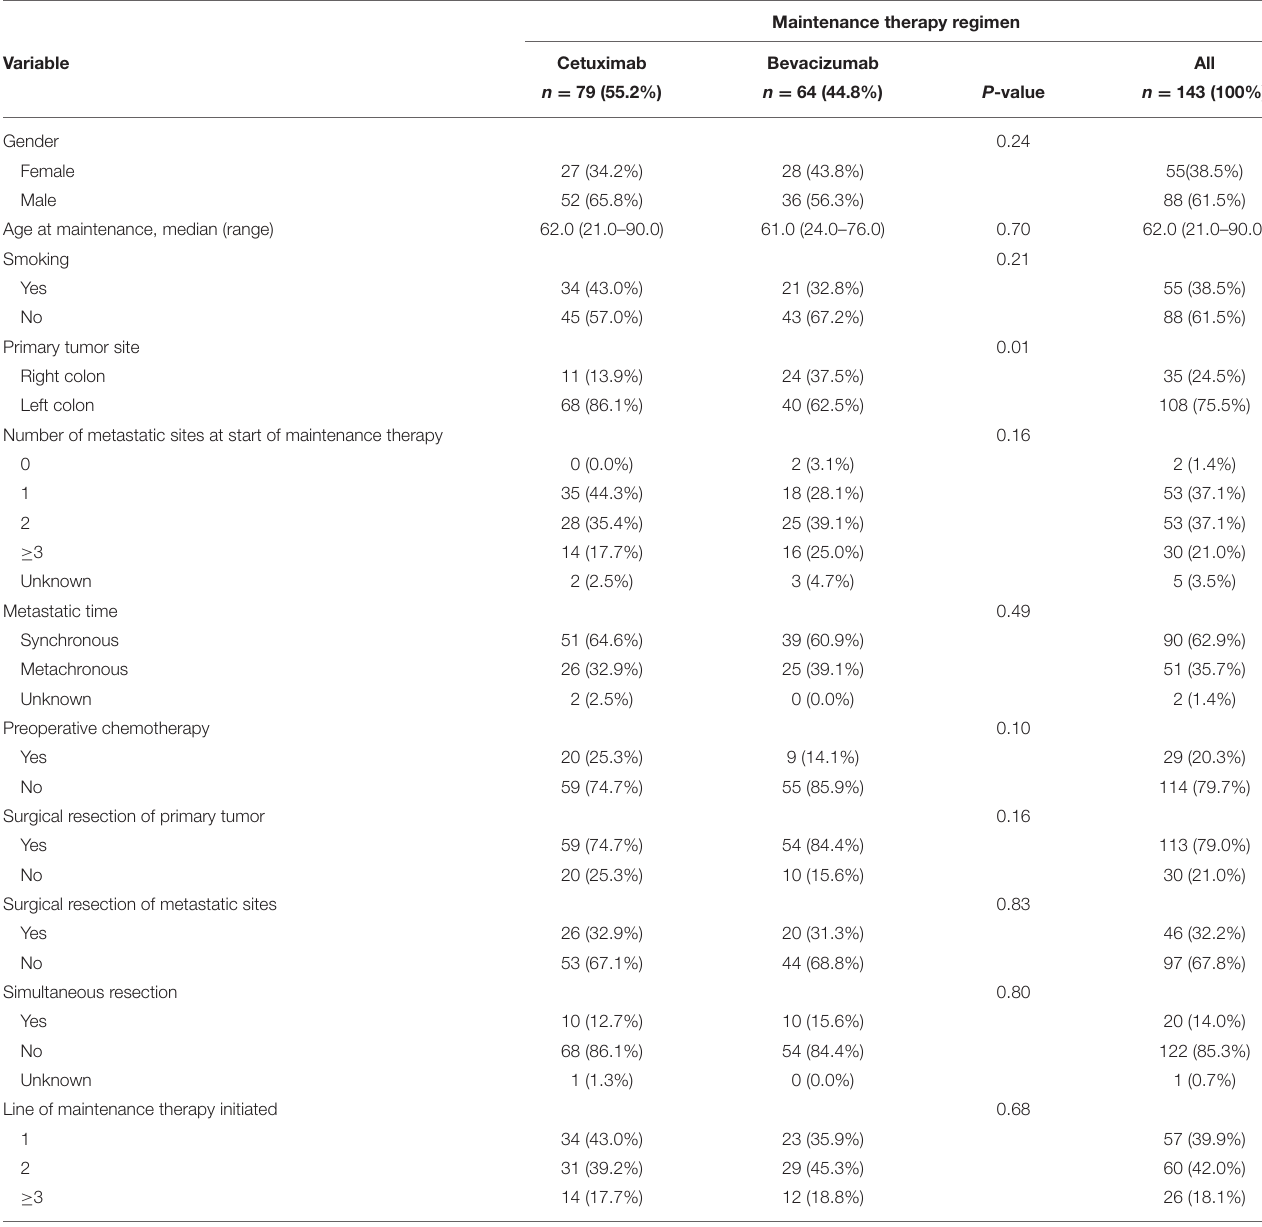
TABLE 1 | Baseline patient